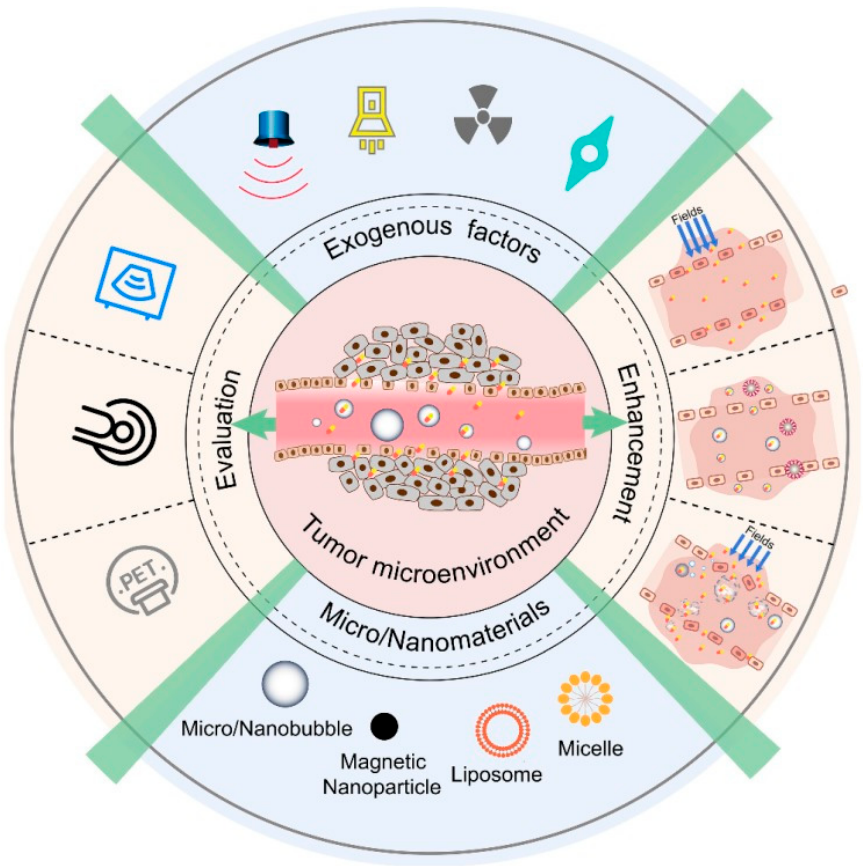
Figure 2. Common strategies utilizing the EPR effect [109].